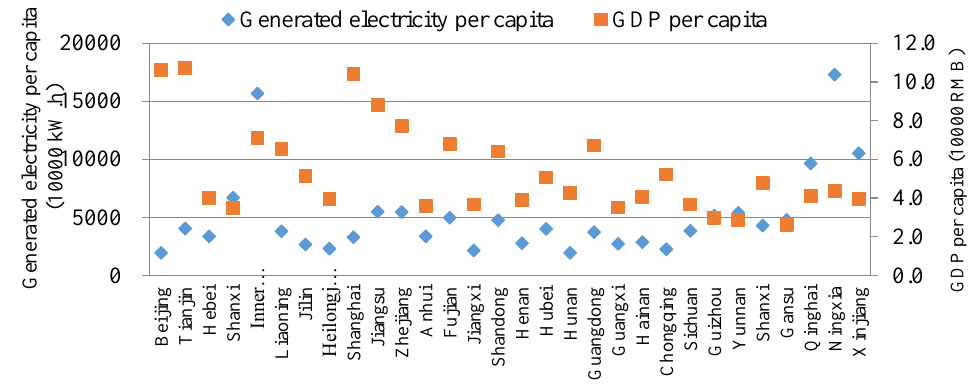
Figure 2. Distribution of GDP per capita and generated electricity per capita of China’s 30 provinces in 2015. * Data source: the website of National Bureau of Statistics of the People’s Republic of China.